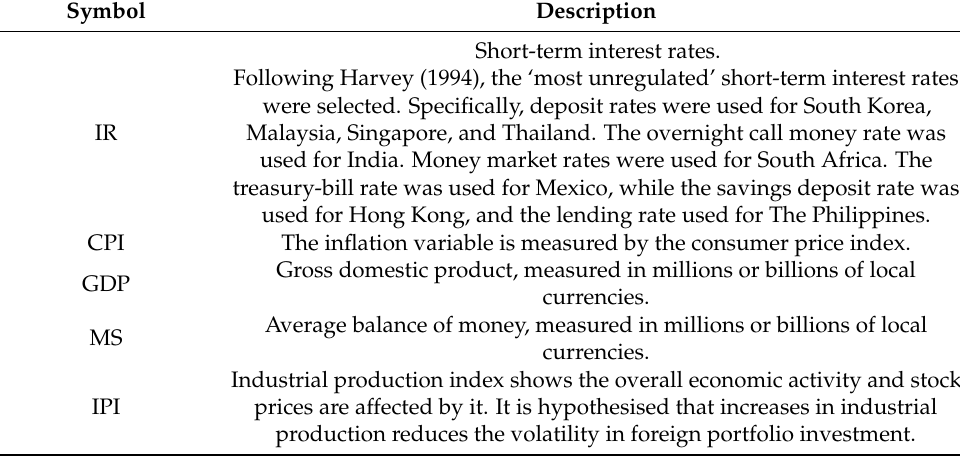
Table 4. List of Macroeconomic